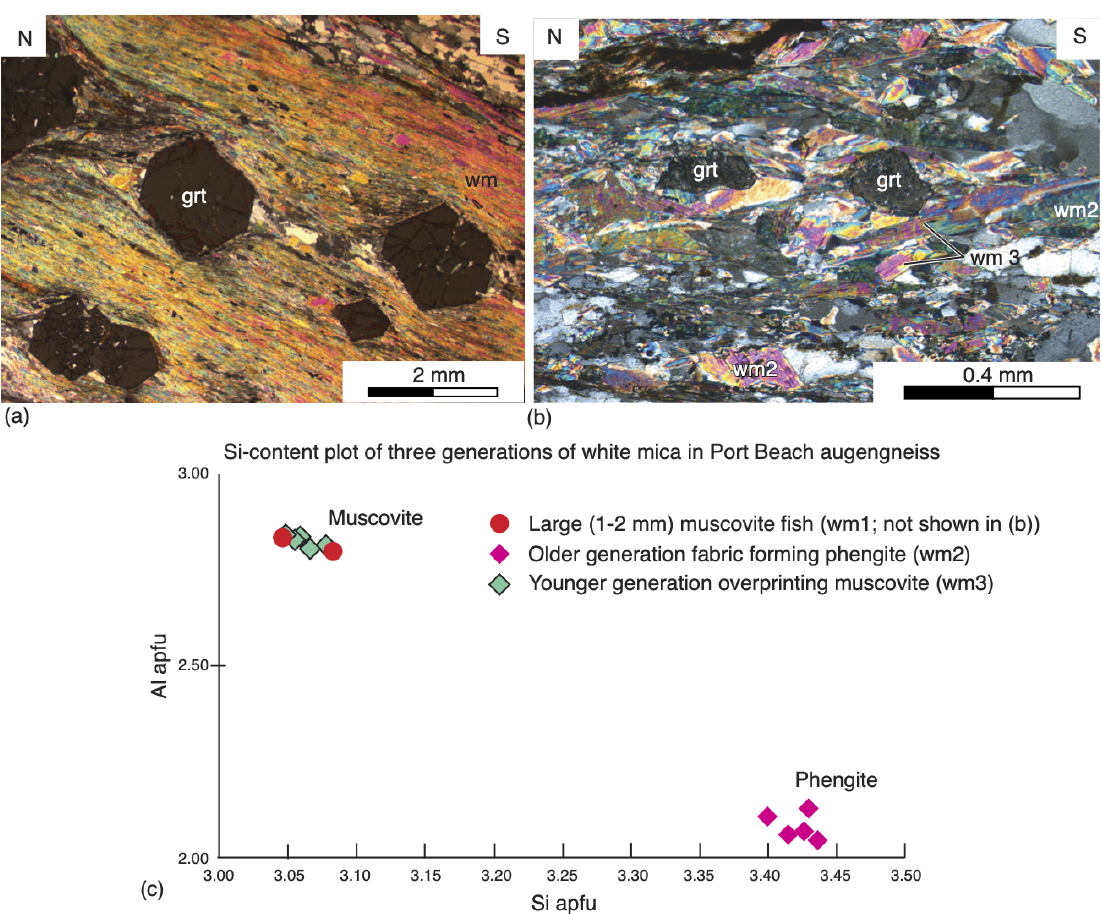
Figure 5. Microstructures analysis in the Port Beach tectonic slice. (a) Garnet porphyroblasts with δ -type pressure shadows in the Port Beach garnet–mica schist (IO18-04). (b) Two generations of overprinted white mica deformation fabrics, with new-grown (wm3) layer- parallel phengite overprinting the “lens”-shaped (wm2) phengite which has its mineral cleavage oblique to the fabric. (c) The plot of Si content illustrating the presence of phengite and muscovite in the Port Beach augengneiss (IO18-01).